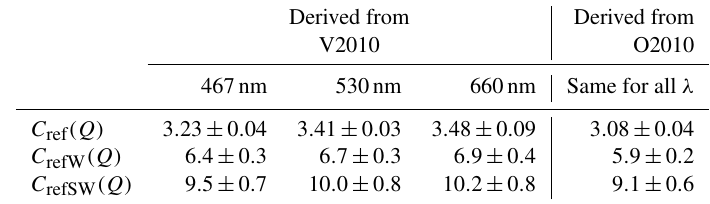
Table 2. Multiple-scattering correction factors of quartz filters. C ref (Q) is derived here for airborne BC particles from published Pallflex filter-loading corrections V2010 and O2010. C refW (Q) is derived here for BC particles mixed in water and filtered through quartz filters. C refSW (Q) is derived here for BC particles mixed in water and treated in an ultrasonic bath and filtered through quartz filters.